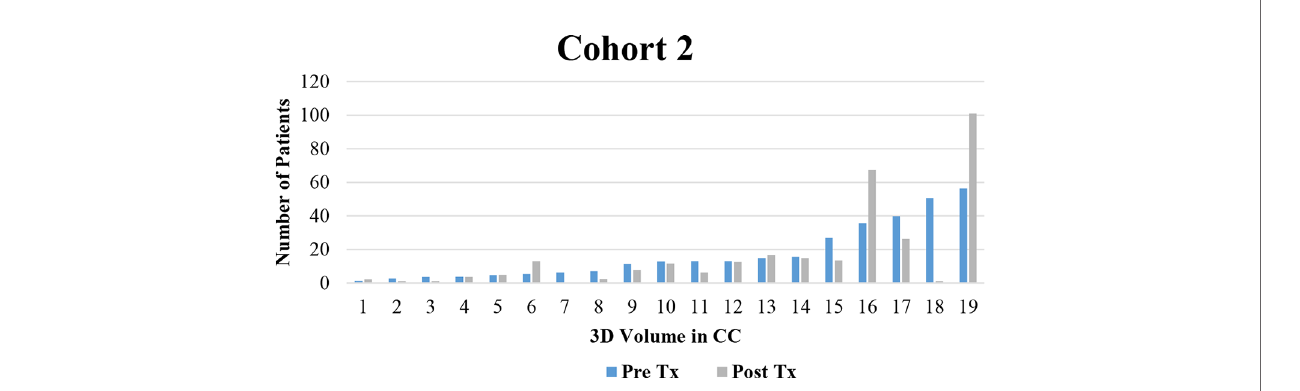
FIGURE 7 | Change in 3D volume which decreased